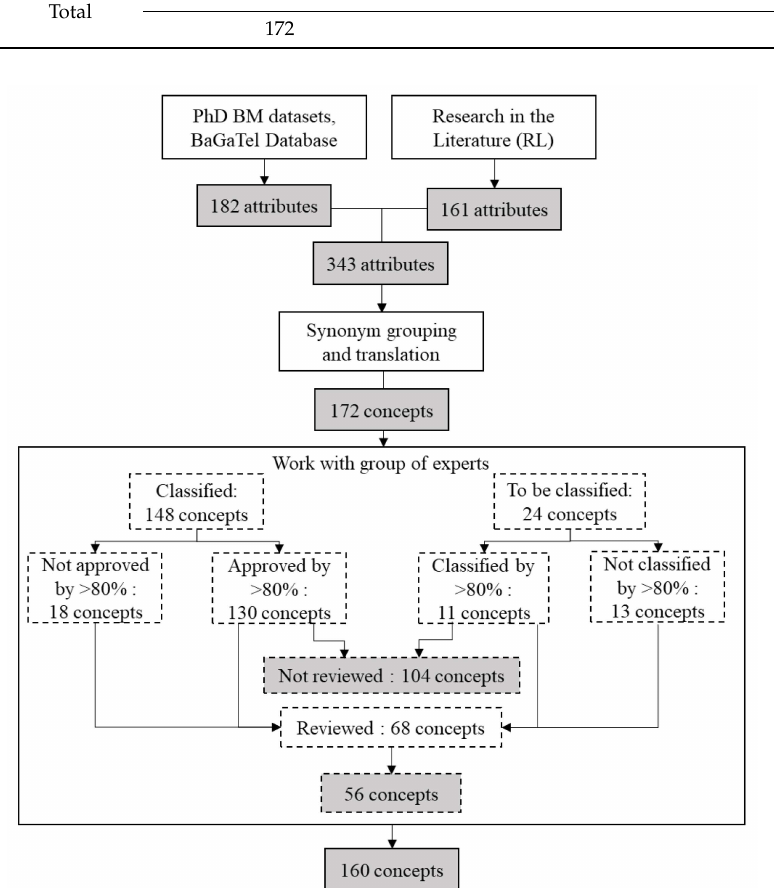
Figure 4. Number of texture attributes before and after step of translation and synonym grouping and after work with the group of